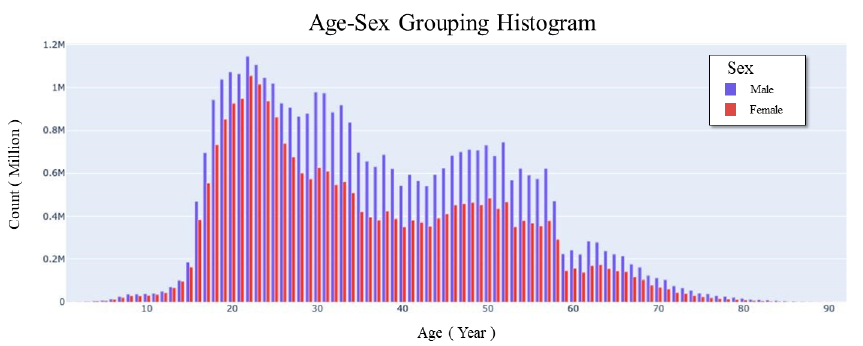
Figure 6. Gender and age statistics of travel population. The abscissa is age, and the ordinate is the number of travellers. The blue column represents males and the red column represents females.Regardless of male or female, there is a small peak in the graph when the age is about 20. The age range of 18 to 26 has a large number of passengers. The men are most distributed between the ages of 20 to 58 years old. Compared with men, females’ age distribution is more concentrated, the number of age of 20 is the